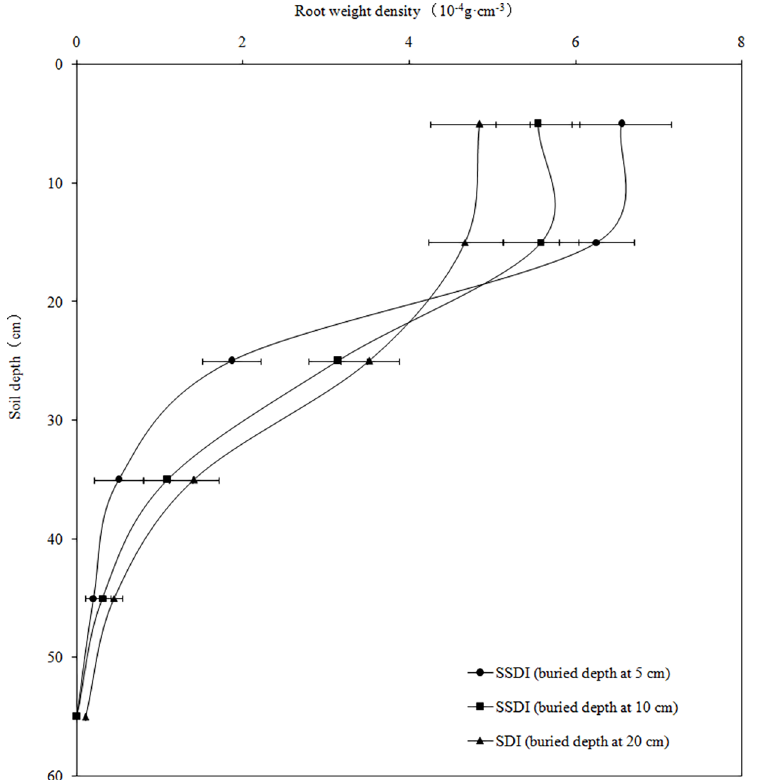
Fig 3. Distribution of root weight density in different soil layers at flowering